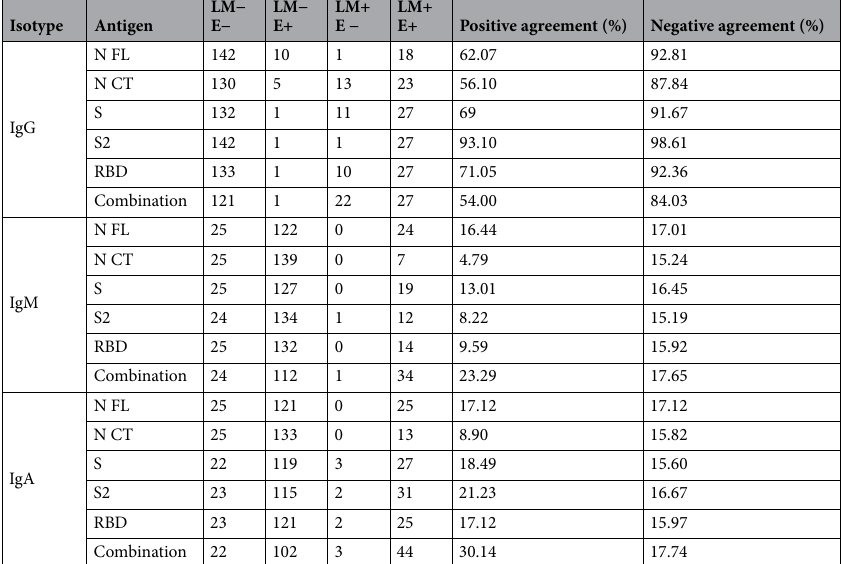
Table 2. Classification of samples by ELISA and Luminex immunoassays for specific IgG, IgM and IgA and percentage of agreement between the tests. The table shows the number of samples classified by the two tests taking into account specific IgG, IgM and IgA against any of the antigens included in the Luminex multiplex panel or the combination of all of them. Concordant samples are those classified as negative (LM− E−) or positive (LM+ E+) by both tests, while discrepant samples are those with opposite results in both tests (LM+ E− and LM− E+). The percentages of agreement were calculated by dividing the concordant positive samples (LM+ E+) or concordant negative samples (LM− E−) by the total of samples that tested positive (LM+ E+, LM+ E−, LM-E+) or negative (LM− E−, LM+ E−, LM− E+) in at least one of the tests, respectively. LM Luminex, E ELISA.